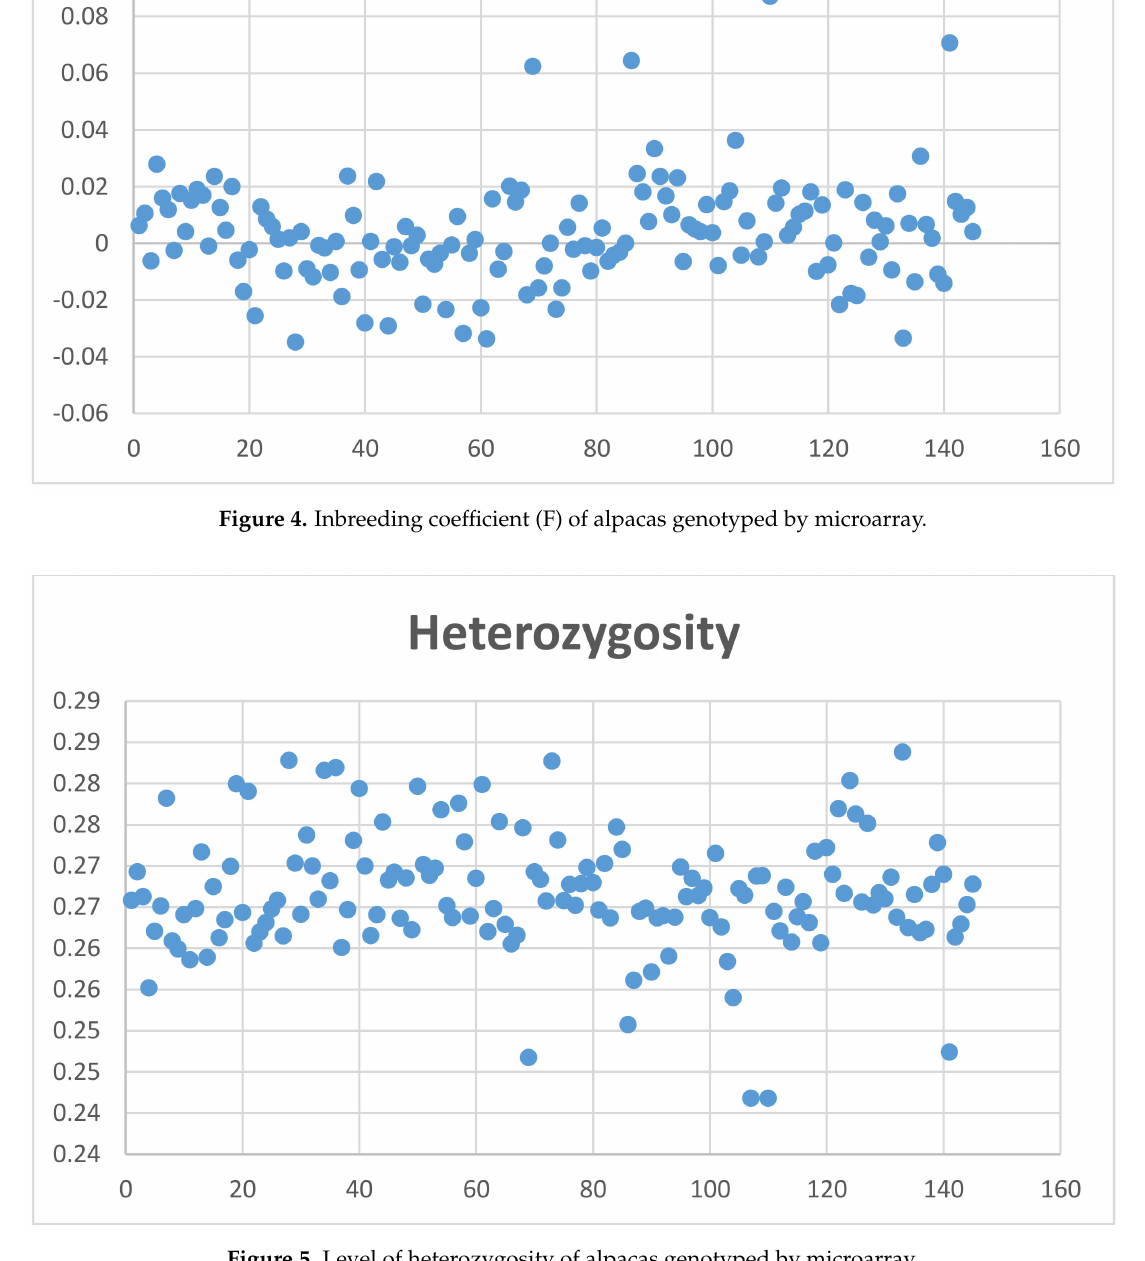
Figure 5. Level of heterozygosity of alpacas genotyped by